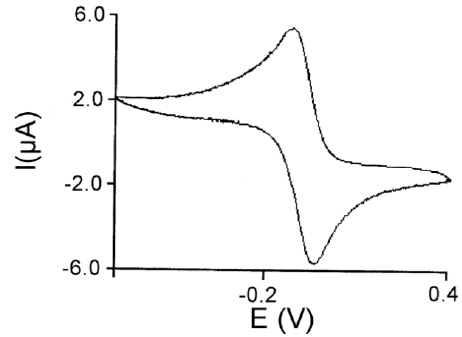
Figure 3. Cyclic voltammogram for 3 at scan rate of 0.02 V s − 1 .